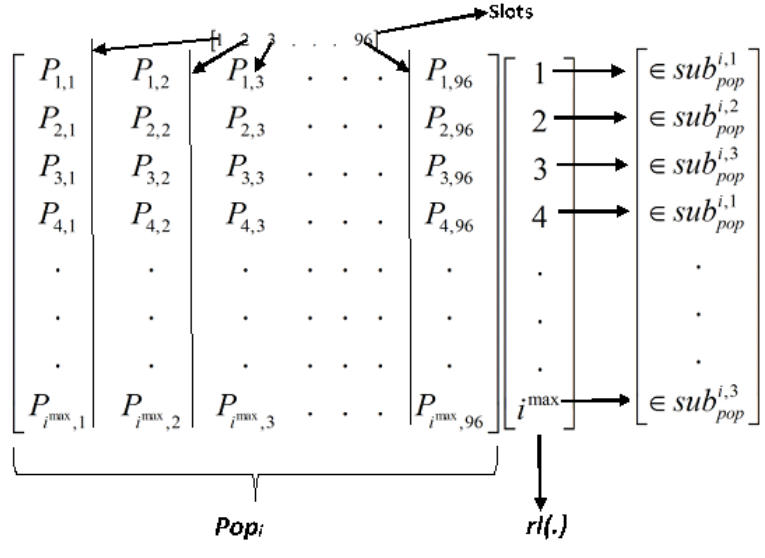
Figure 5. pop i with its